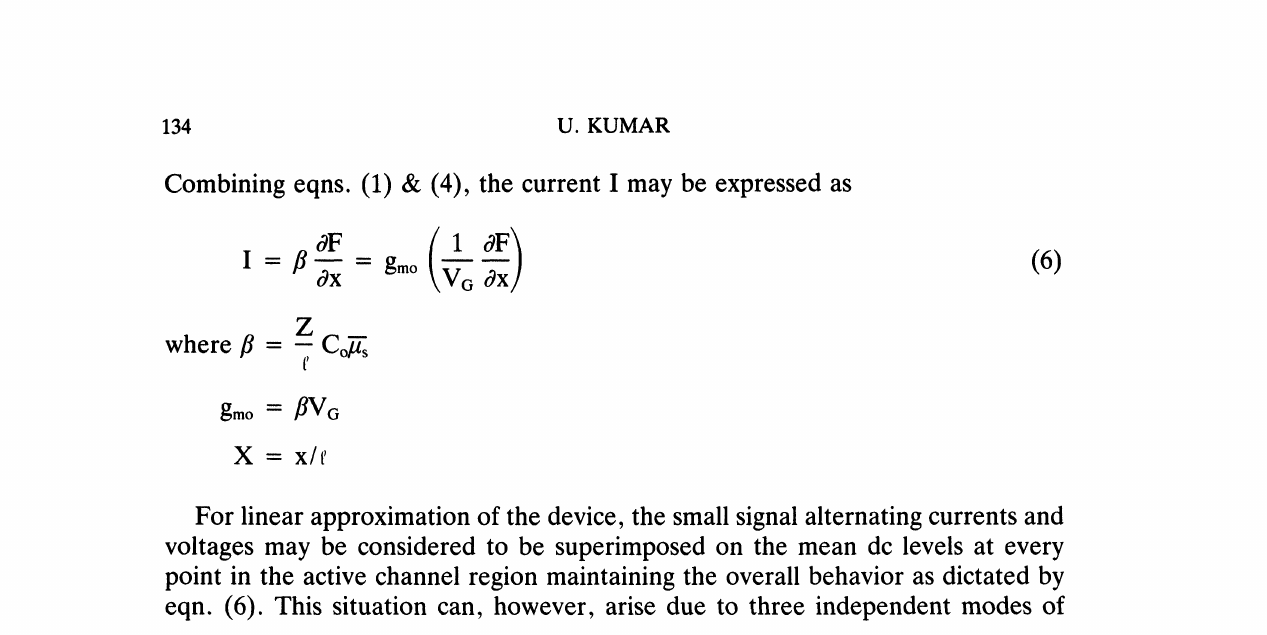
Comparison of the differential equations representing the device and the RC transmission line analogs System description Differential equations Boundary equations